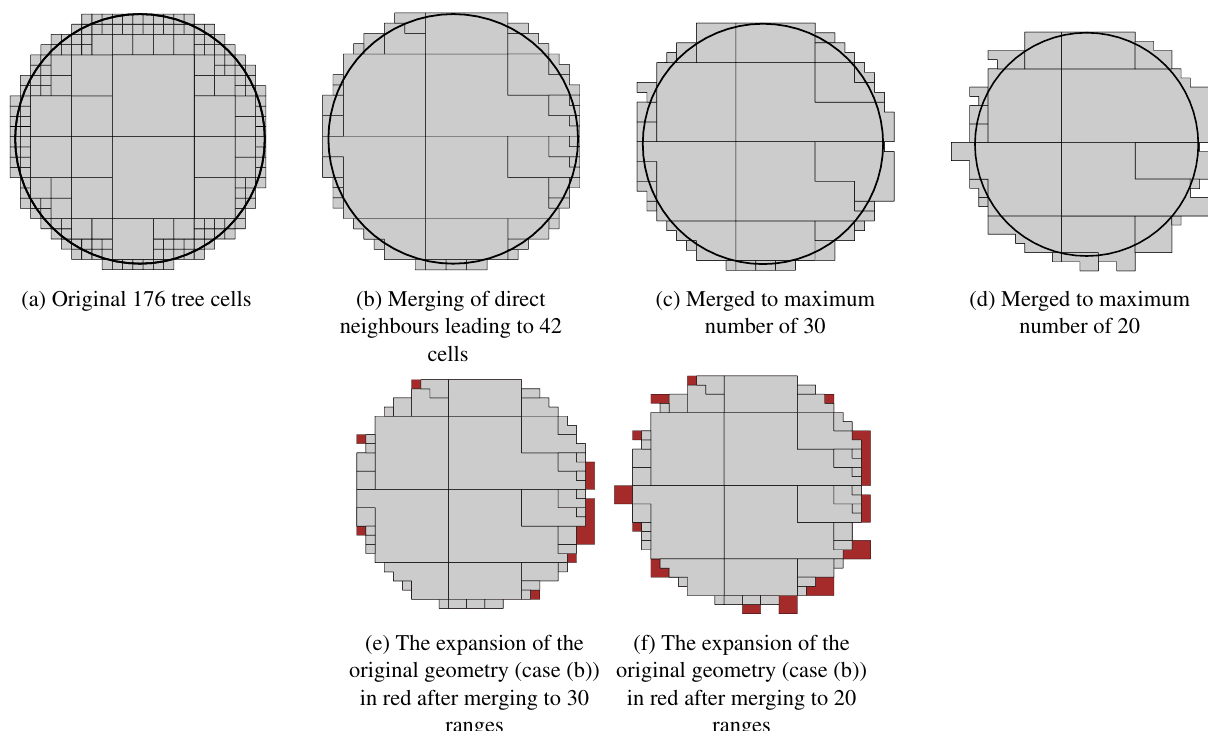
Figure 4: The different steps in the preparation of the filter step: Tree cell identification, direct neighbour merging and, merging to maximum number. Cases (c) and (d) depict different degrees of merging applied to the tree cells of case (b). The expansion of the area according to the two degrees of merging (30 and 20) is shown in cases (e) and (f) respectively